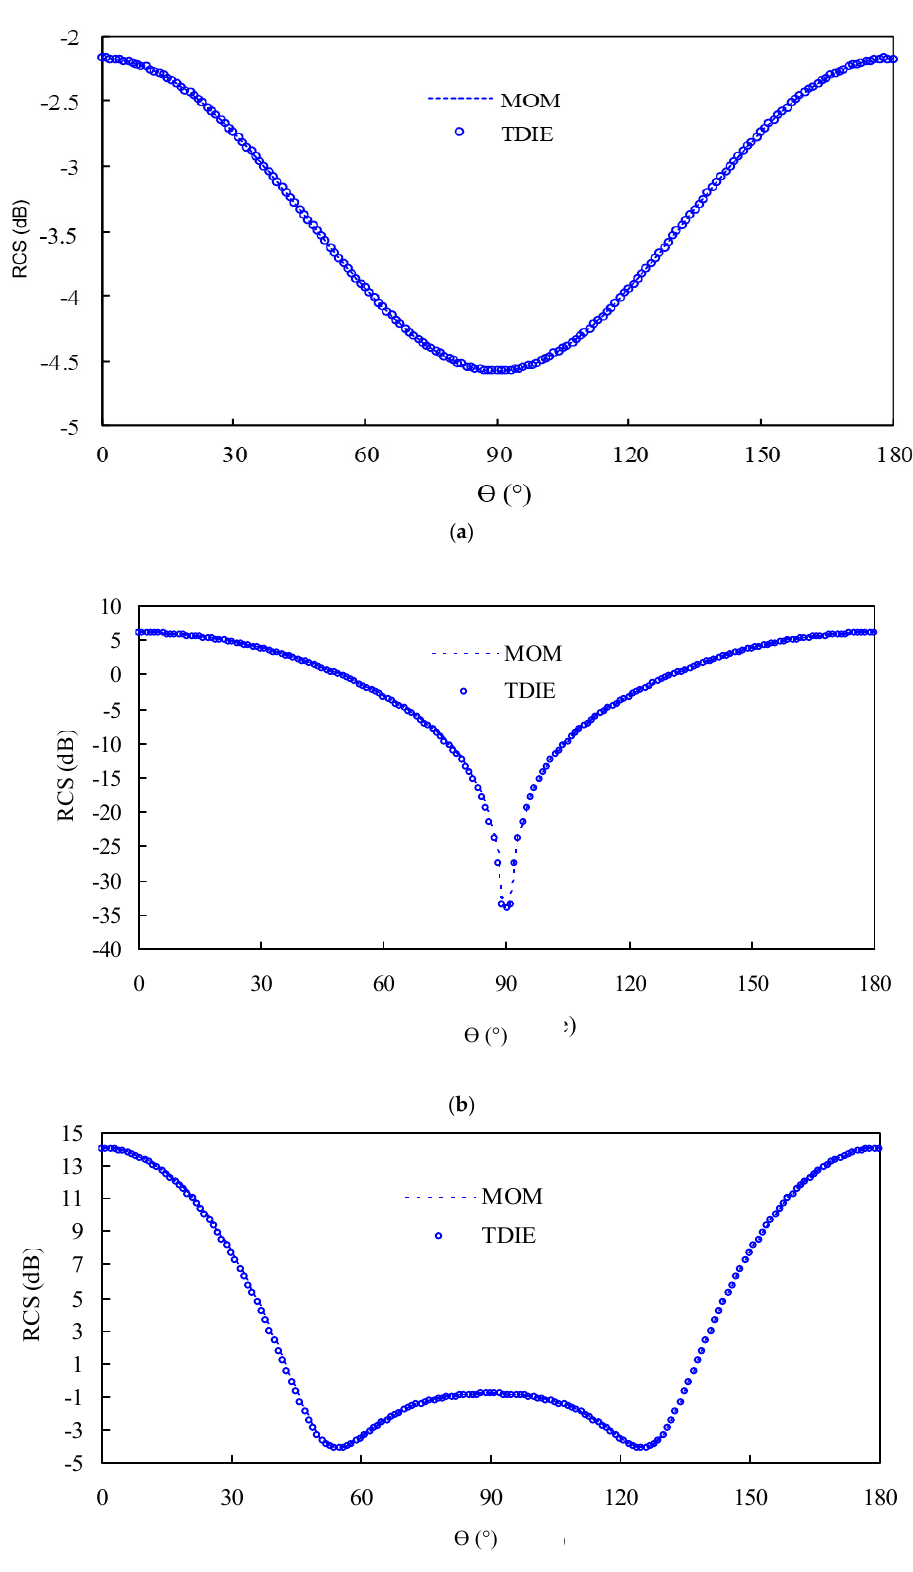
Figure 3. φ = 90 ◦ bistatic radar cross section (RCS) of the graphene sheet: ( a ) 0.102 THz; ( b ) 0.204 THz; ( c ) 0.374